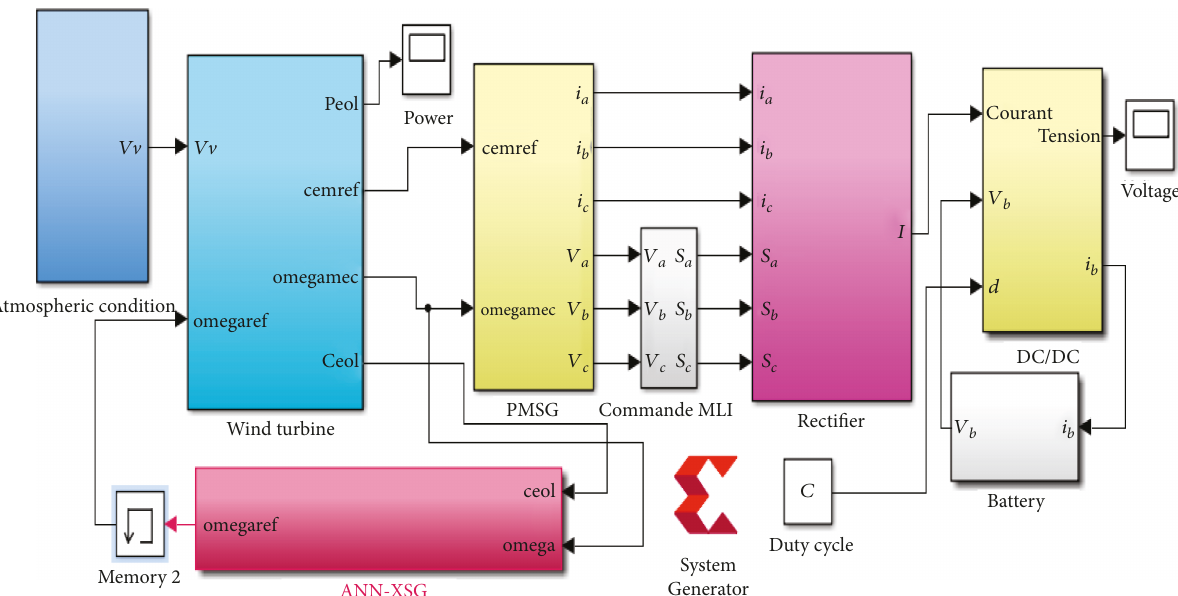
Figure 11: MATLAB/Simulink diagram of the wind energy conversion